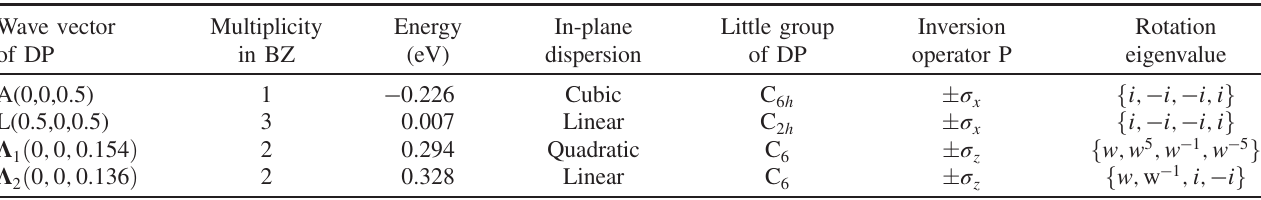
TABLE I. Different types of Dirac points and their physical properties in Tl ð MoTe Þ 3 . Note that the energy of DP is related to the Fermi level, and w ¼ e i π = 6 .